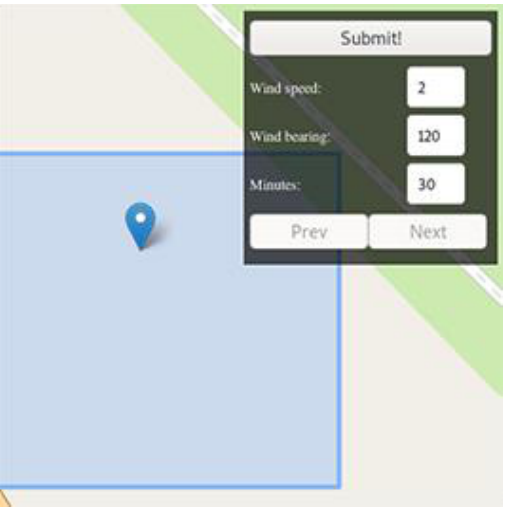
Figure 6: Simplified user interface, simulation extent (blue polygon), and fire origin (blue